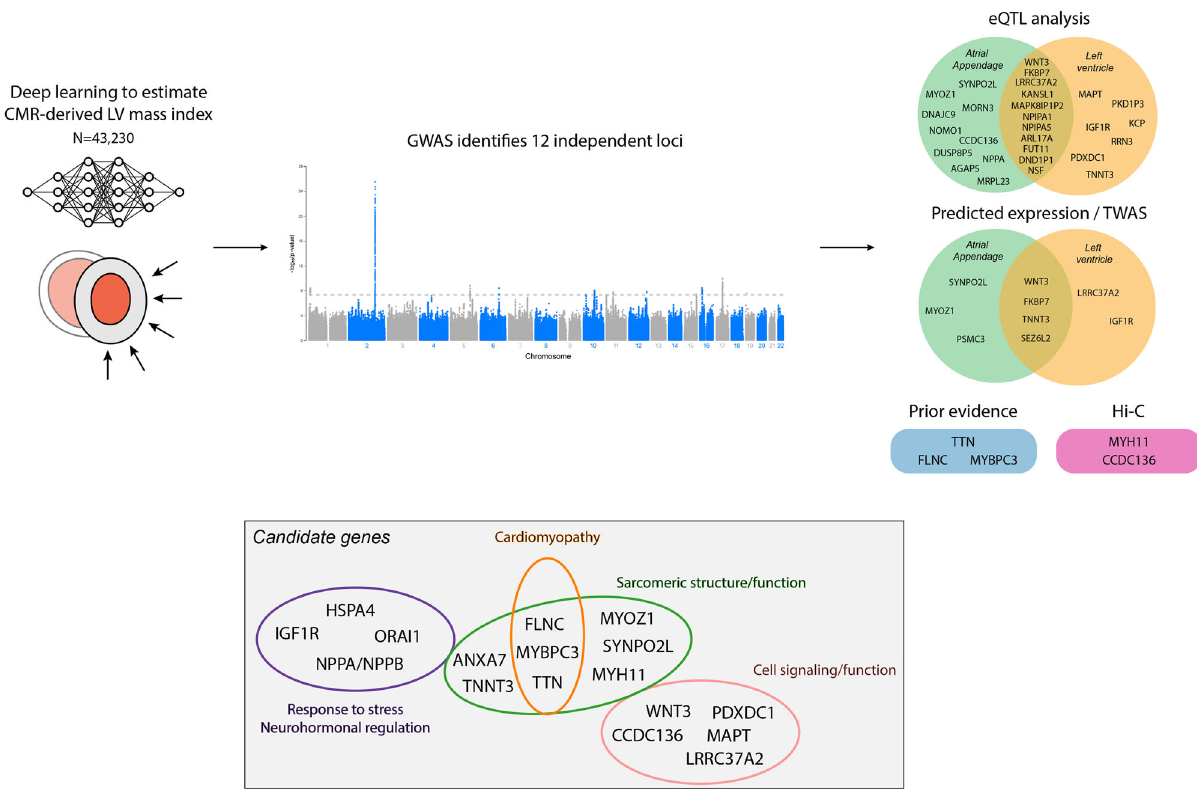
Fig.3|Candidategenesummary. Depictedisasummaryofstudyresults.Weused a deep learning algorithm to perform a GWAS of CMR-derived LVMI in 43,230 individuals, fi nding 12 independent loci associated with LVMI. Using proximity to lead variants, expression quantitative trait locus (eQTL) analysis, transcriptome- wide association studies (TWAS), Hi-C analysis, LV tissue-speci fi c expression